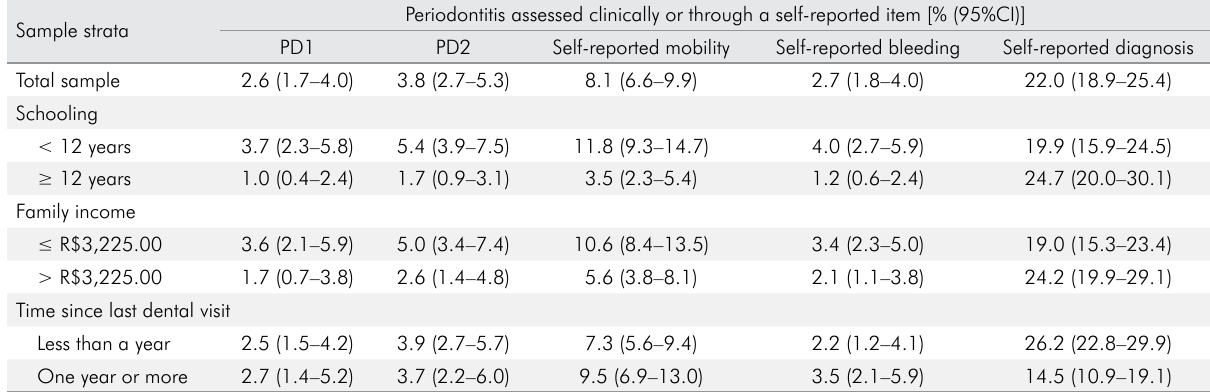
Table 2. Periodontal conditions (%) by clinical exam and self-reported items (n = 1,140). EpiFloripa Study, Florianópolis, Southern Brazil, 2012.